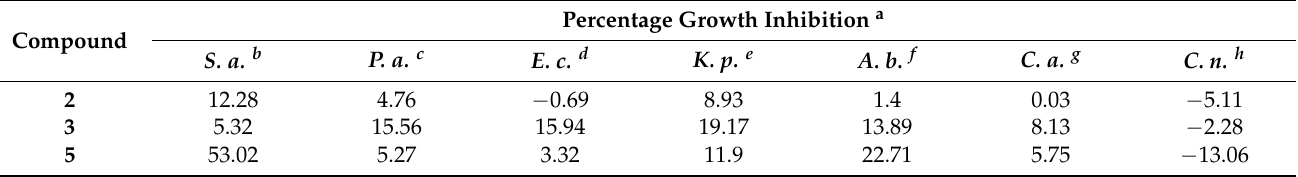
Table 2. Antimicrobial activities of 2 , 3 , and 5 .